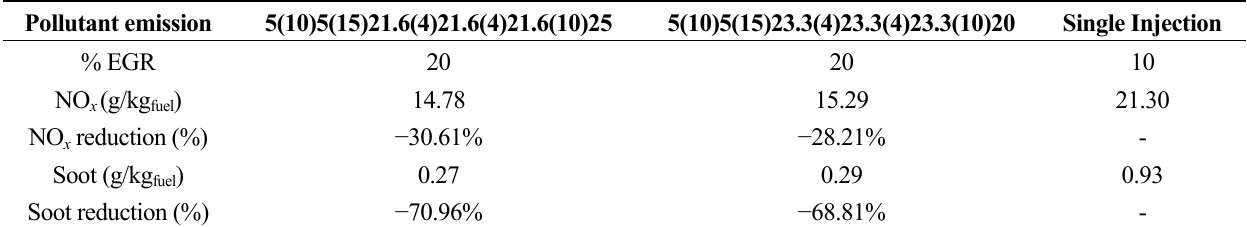
Table 5. Comparison between best simulations and experimental data at 10%